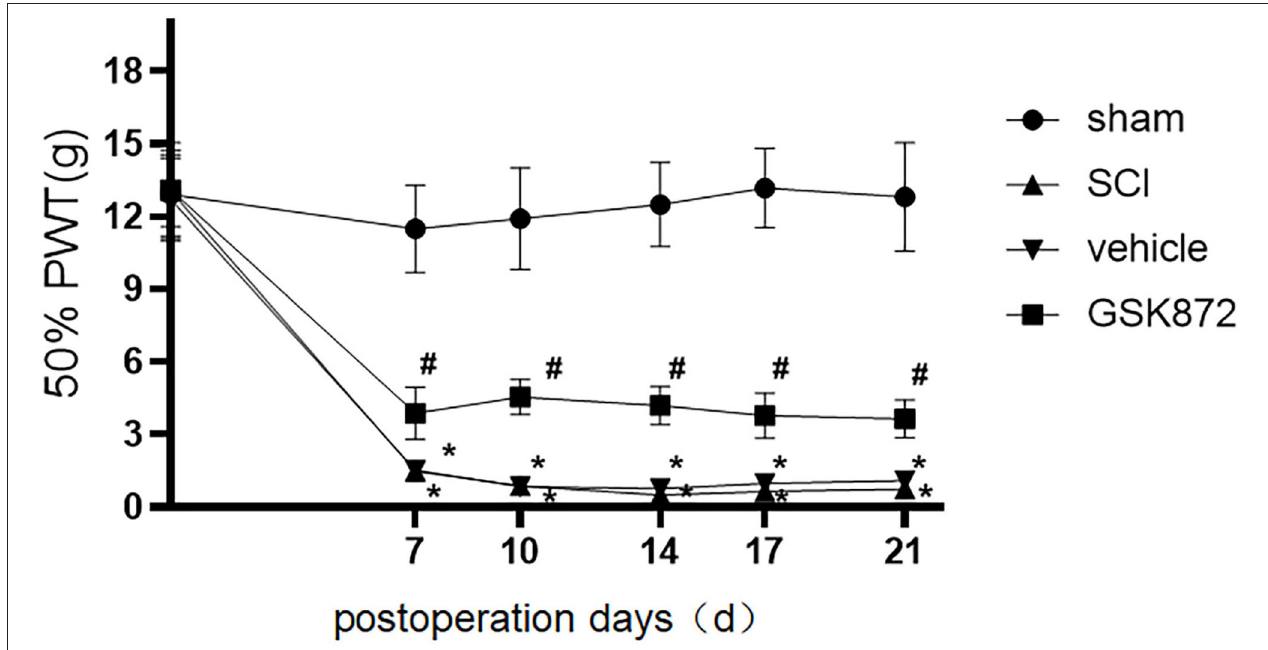
FIGURE 1 | Intrathecal administration of GSK872 (10 µ l, 25 mmol/L) attenuated mechanical hypersensitivity induced by SCI ( n = 7 for each group). All data were calculated as mean ± SD. * p < 0.05 vs. the sham group; # p < 0.05 the vehicle group. Comparisons between multiple groups were conducted by repeated-measures analysis of variance and Turkey’s post-hoc analysis SCI: spinal cord injury. 50% PWT, fifty percentage paw withdrawal threshold.